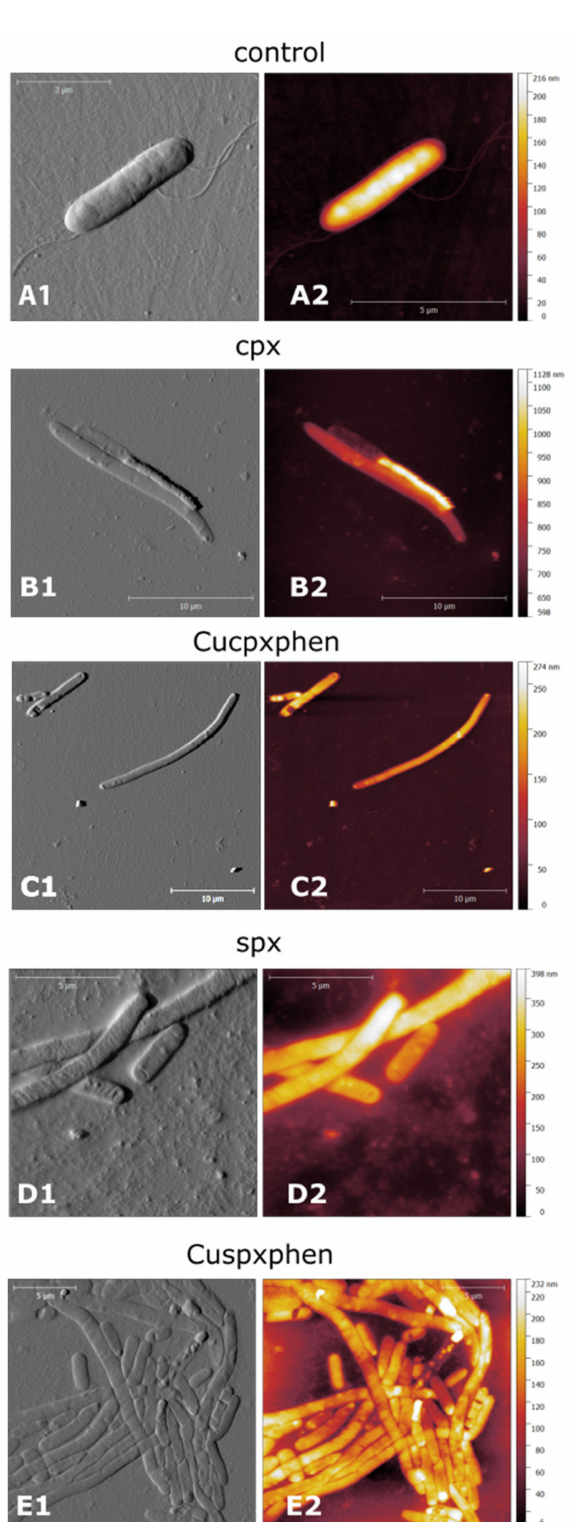
Figure 6. AFM images of E. coli ATCC 25922 control cells ( A ) and cells treated with cpx ( B ), Cucpx- phen ( C ), spx ( D ), and Cuspxphen ( E ). A1, B1, C1, D1, and E1 are amplitude images; A2, B2, C2, D2, and E2 are height images. Images are representative of multiple areas from at least three samples analysed for each condition tested. Reprinted with permission from International Journal of Environ- mental Research and Public Health, 17, Ferreira, M., Bessa, L. J., Sousa, C. F., Eaton, P.,